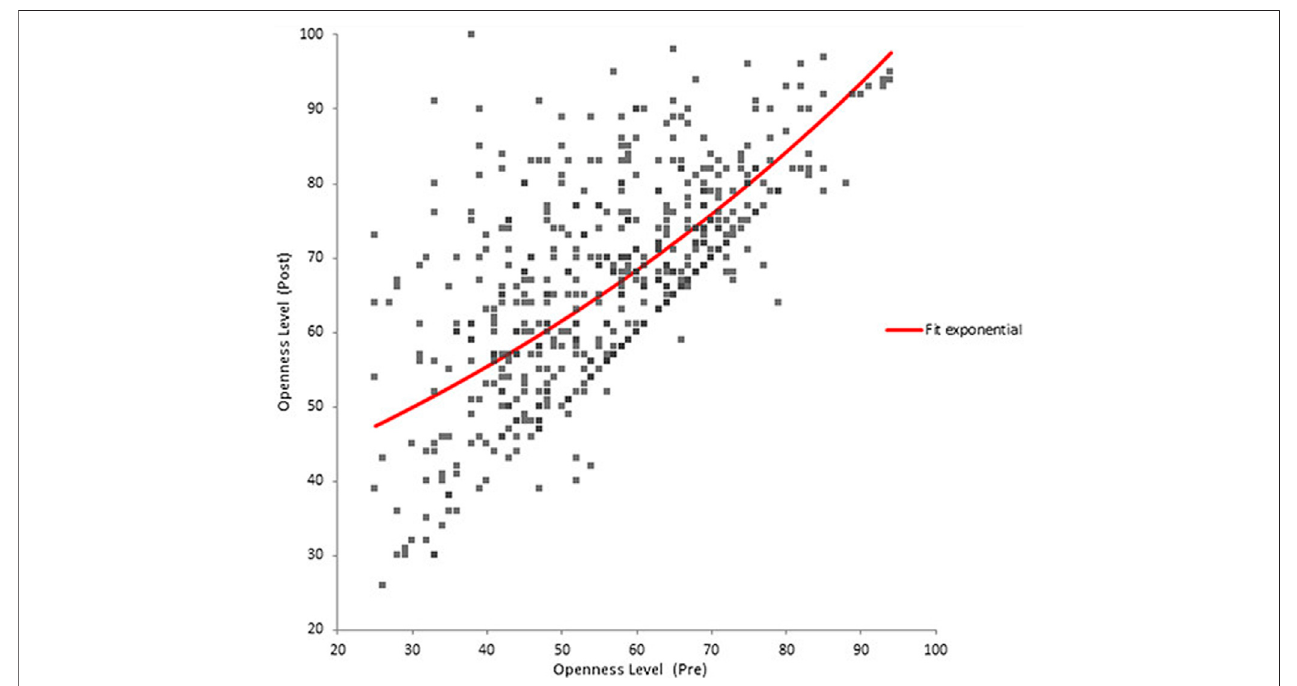
FIGURE1| Thegraphpresentsthepre-andpost-opennesslevelsofthe500schoolsthatwereinvolvedinthestudy,afteroneacademicyearofimplementationof the open schooling activities in their settings. The data (post- vs. pre-measurement) demonstrate signi fi cant growth in openness ( > 11% on average) while the growth is much higher for less advanced schools (goes up to 45%) in a one-year intervention. The fi t line represents the average growth of the participating schools according to their pre-measurement.